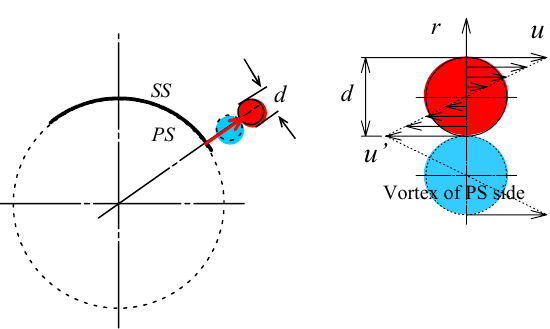
Fig.8 Schematic diagram of local lift induced by